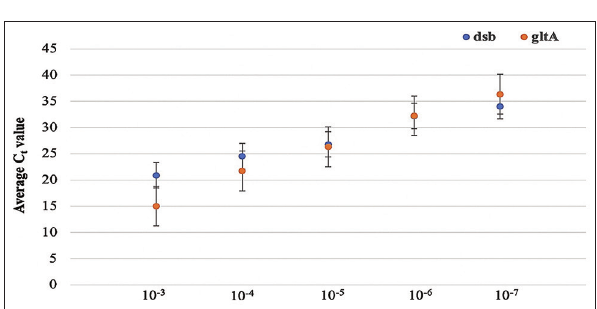
Figure-1: Regression analysis for TaqMan amplification from 10-fold serial dilution of pGEMT- dsb and pGEMT- gltA . The mean cycle threshold (Ct) value is plotted against the known dilutions and the error bars show the standard deviation around this